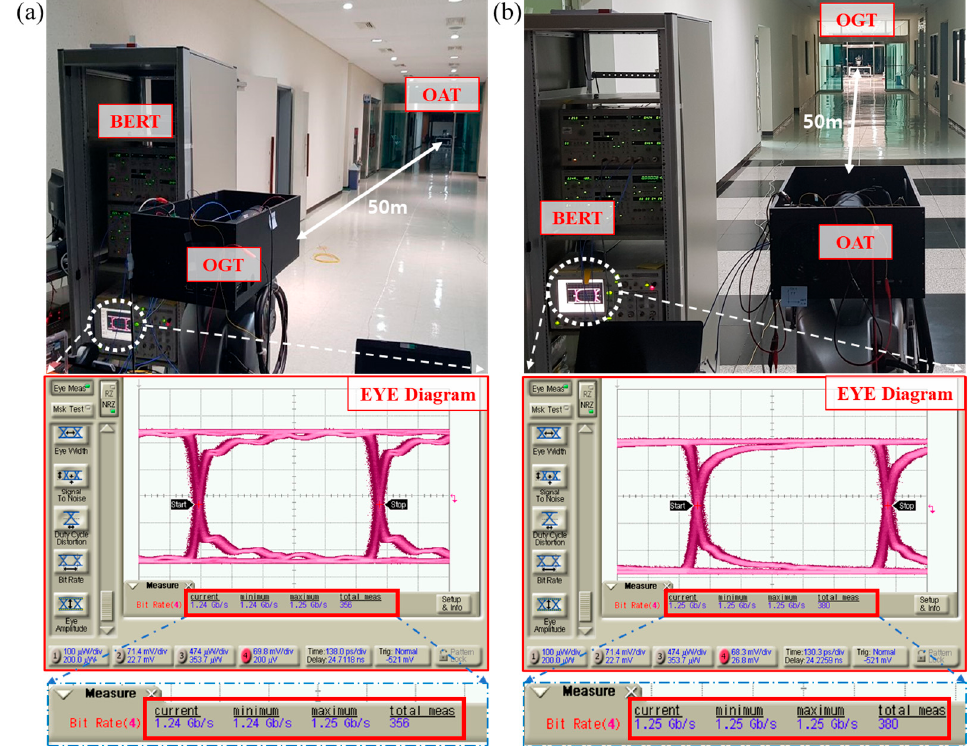
Figure 7. Bit error rate (BER) measurement of FSO link between OGT and OAT at 50 m distance: ( a ) OGT to OAT and ( b ) OAT to OGT.